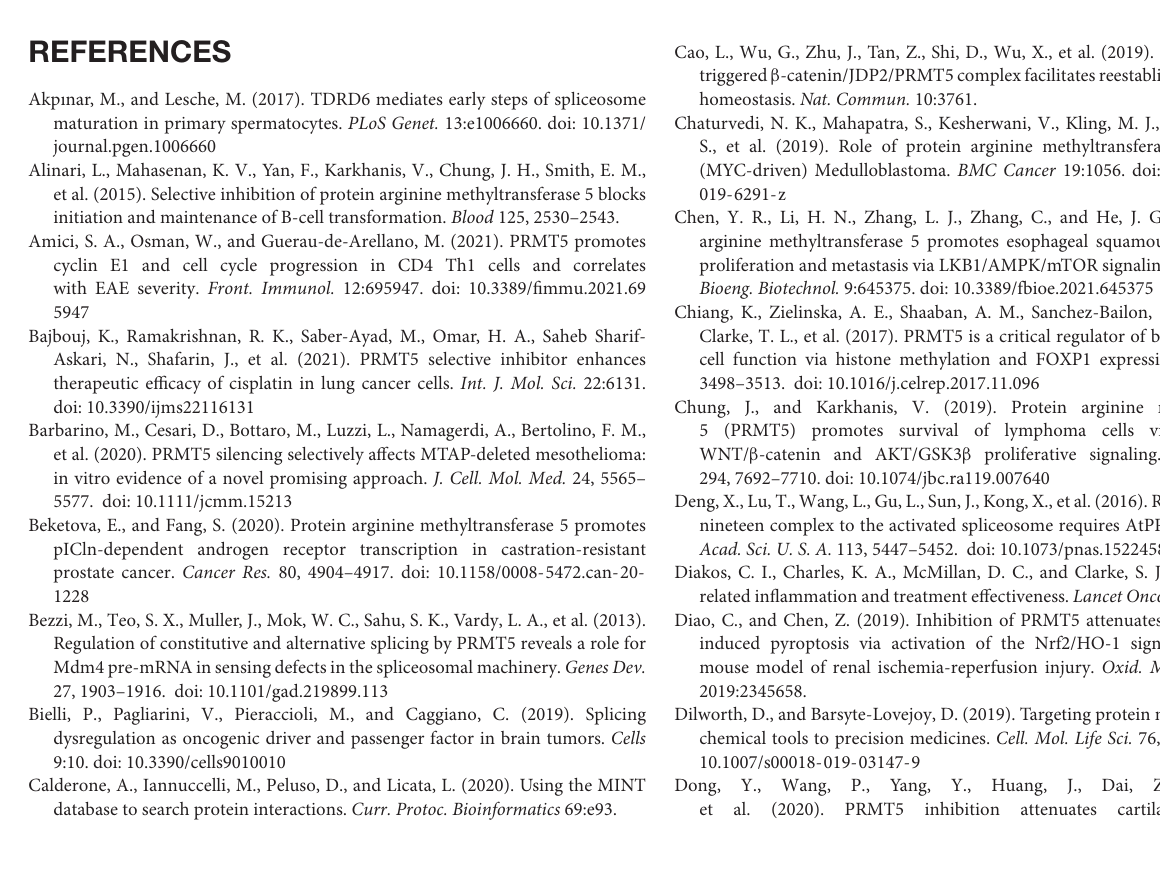
Supplementary Table 1 | The interacting proteins of PRMT5 predicted in 6 protein-protein interacting databases. Supplementary Table 2 | GO Enrichment analysis of PRMT5 interacting proteins. Supplementary Table 3 | KEGG Enrichment analysis of PRMT5 interacting